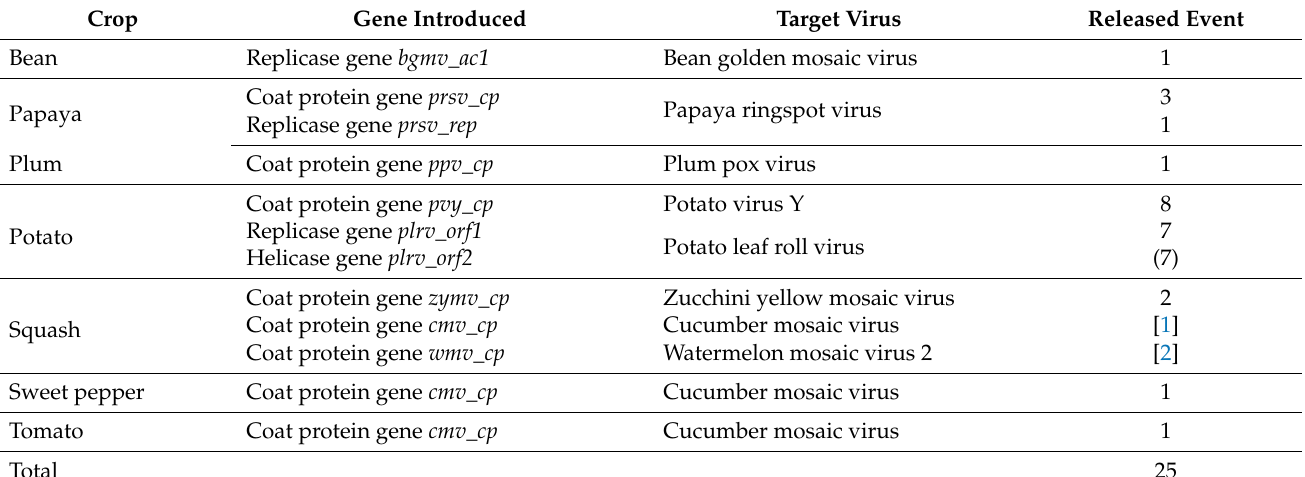
Table 2. Number of RNAi transgenic events of viral resistance authorized for cultivation and